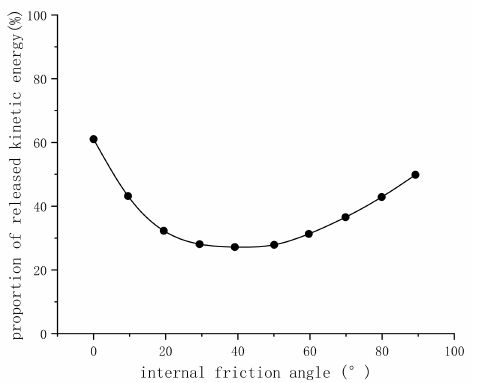
Figure 3. The relationship between released kinetic energy and the internal friction